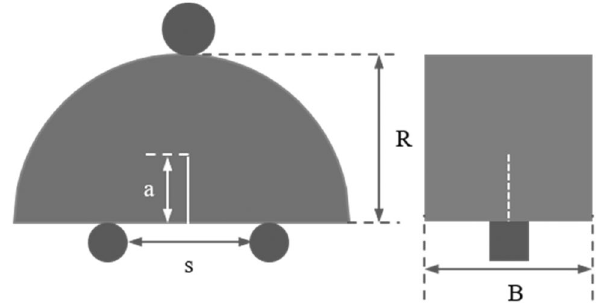
Figure 2. The schematic loading arrangement of tuff SCB specimen.